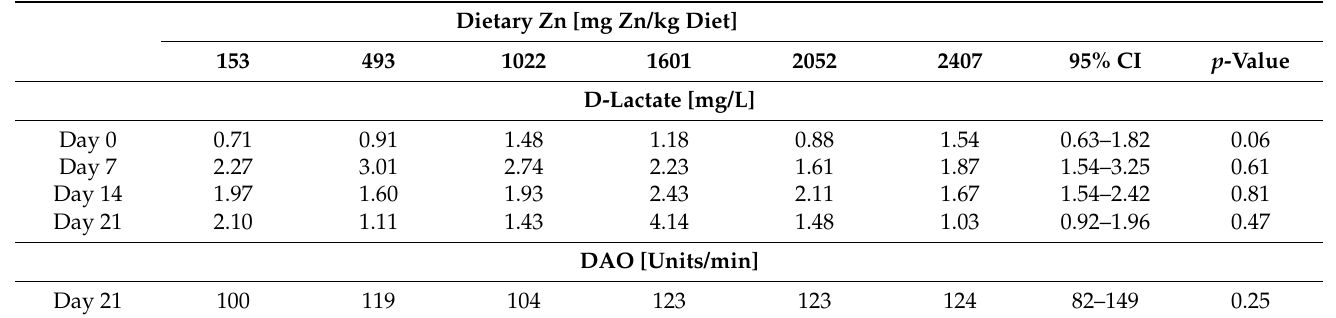
Table 5. Effect of dietary Zn level on D-lactate concentration and diamine oxidase (DAO) activity in plasma.